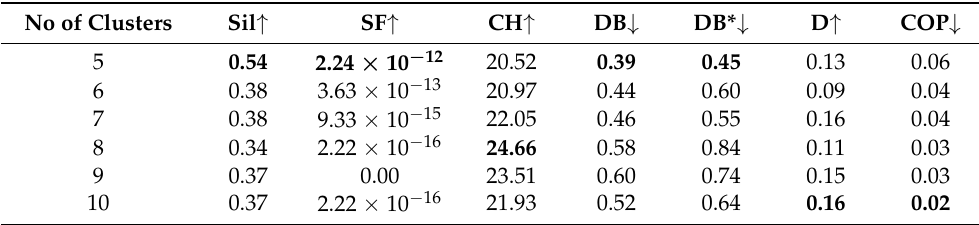
Table 2. CVIs results for the univariate time series analysis on Cr(VI) data: Silhuette (Sil), to be maximized; Dunn index (D), to be maximized; COP index (COP), to be minimized; Davies-Bouldin index (DB), to be minimized; Modified Davies-Bouldin index (DB*), to be minimized; Calinski- Harabasz index (CH), to be maximized; Score Function (SF), to be minimized. Bold font indicates the best solution according to each